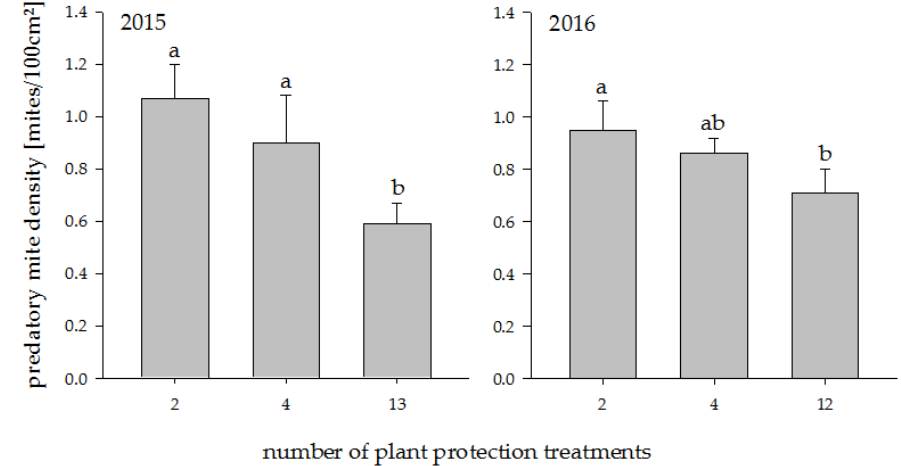
Figure 1. Predatory mite density in plots with increasing plant protection intensities in the years 2015 and 2016. Different letters indicate significant differences between groups ( p < 0.05). Values represent means + standard error (N = 24).